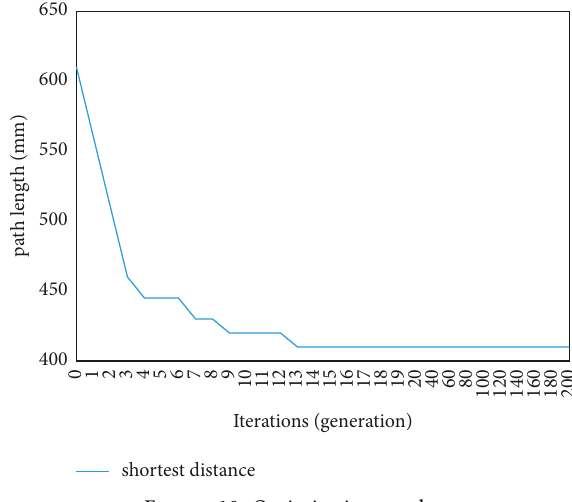
Figure 10: Optimization